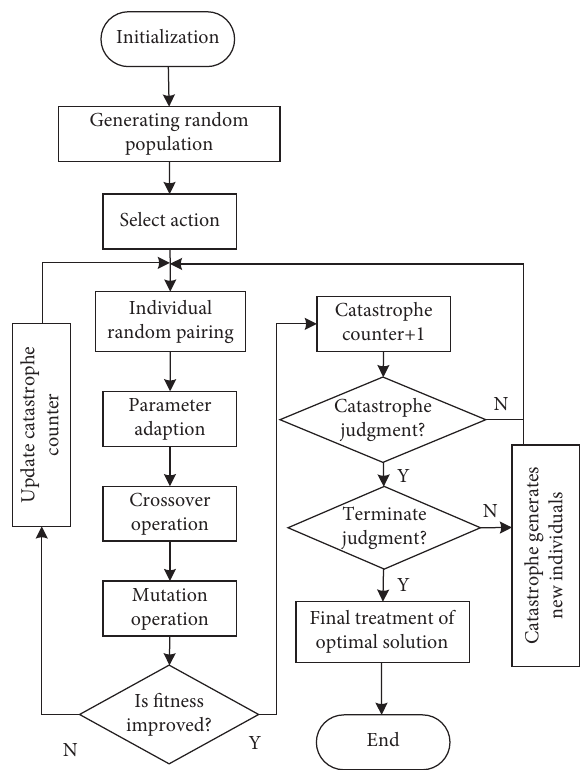
Figure 2: Adaptive catastrophe algorithm